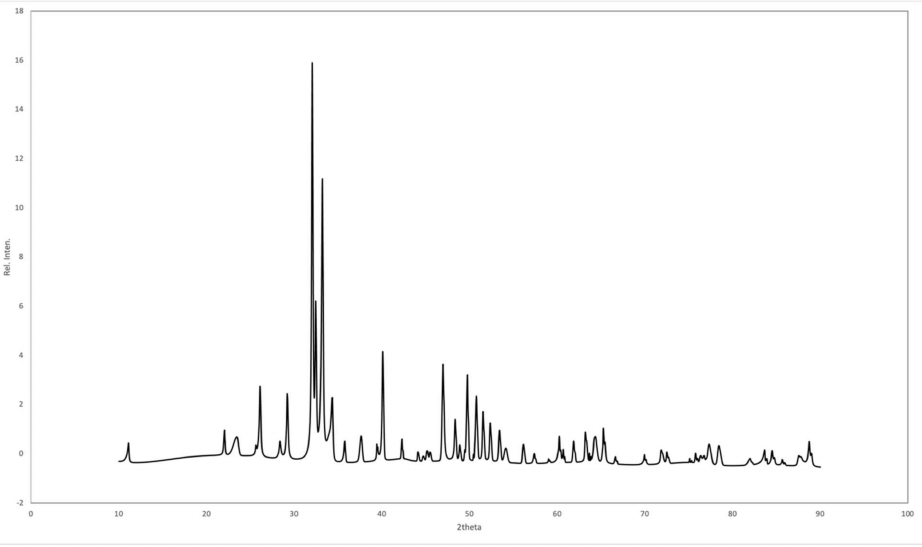
Figure 4. XRD patterns of the sintered CBHA powder.